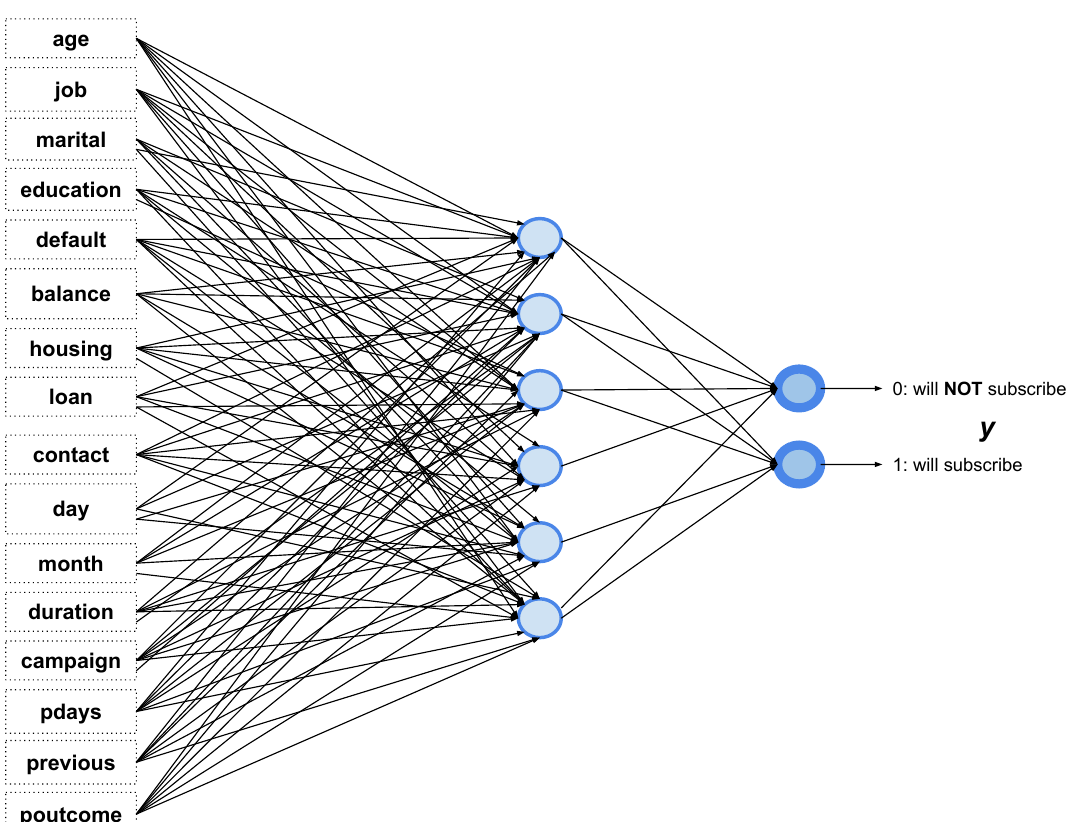
Figure 1. Multilayer Perceptron Artificial Neural Network